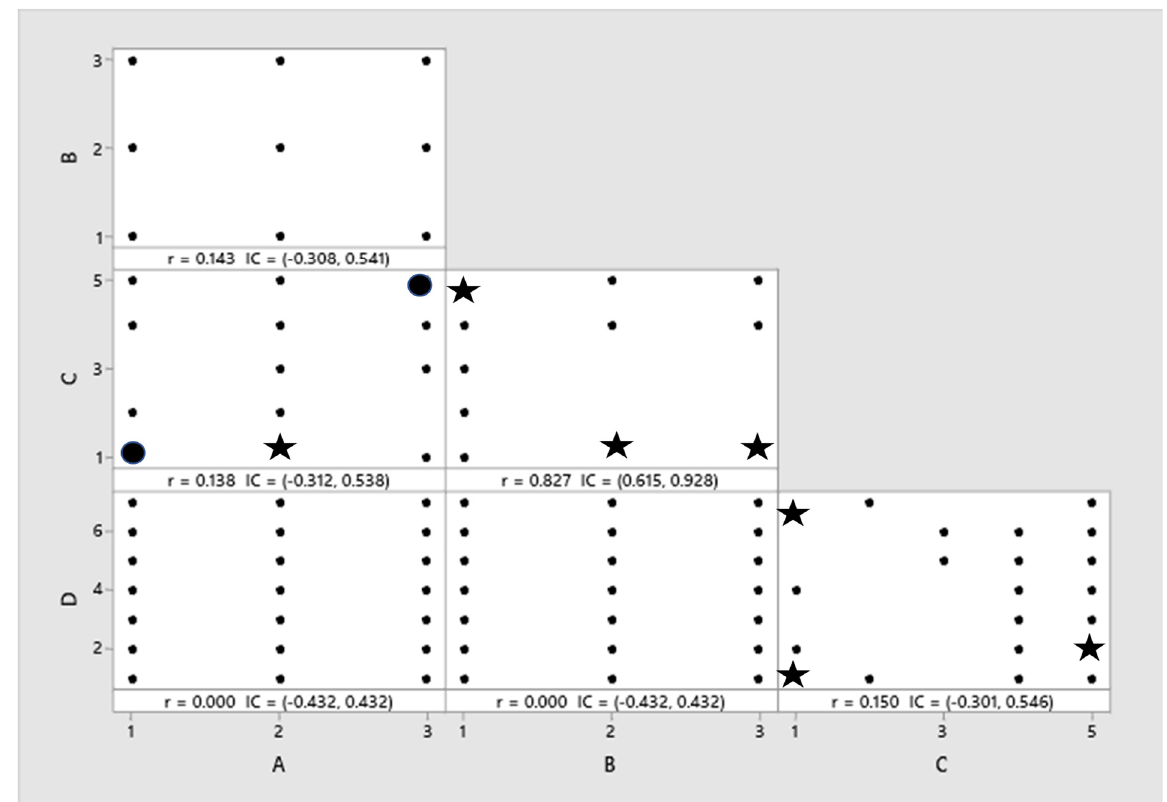
Figure 12. Assignment of signs for columns A and D.